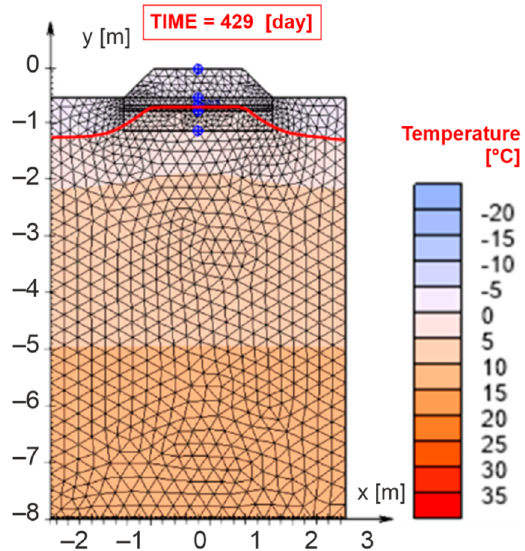
Figure 9. Results of numerical analysis.